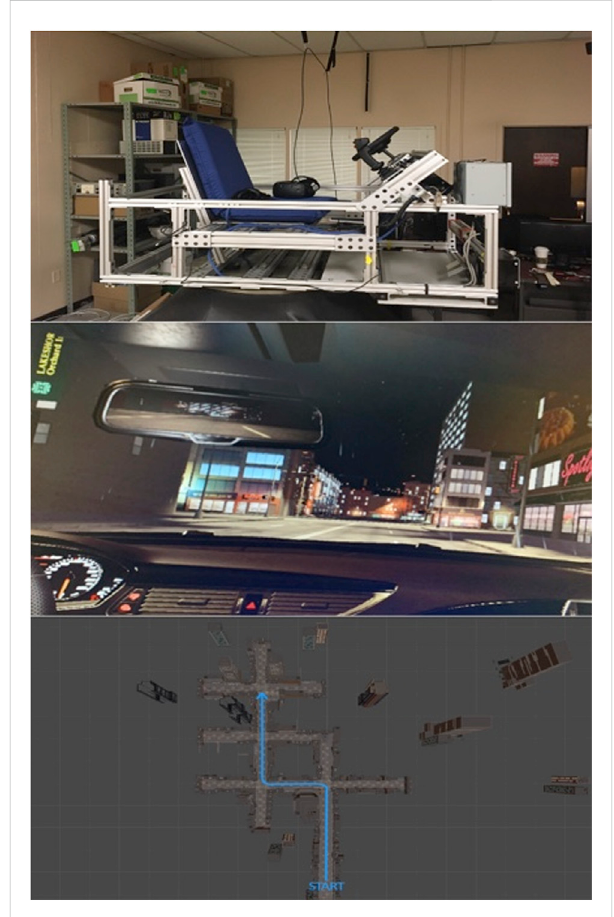
VISION Platform, virtual display of participant while using VISION platform and route taken by virtual car during crash